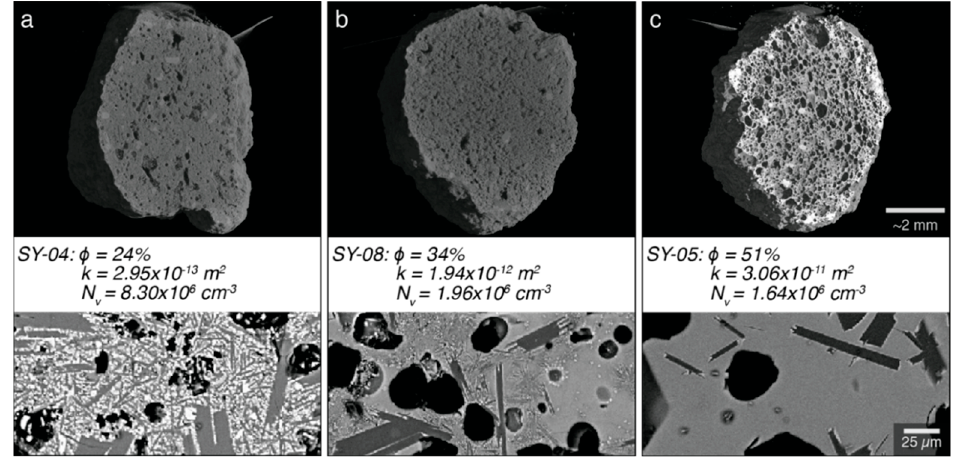
Figure 7. Lapilli textures. Vesicle textures shown as µ -cT reconstructions (top panels), sample names and data reprinted from Table 2 (middle panels), and groundmass textures (bottom panels). Note that from ( a – c ), porosity (in this figure = φ ) and permeability (k) increase, number density (N v ) and groundmass crystallinity decrease from tachylite ( a ) to transitional ( b ) to sideromelane ( c ). Porosity and permeability data are from